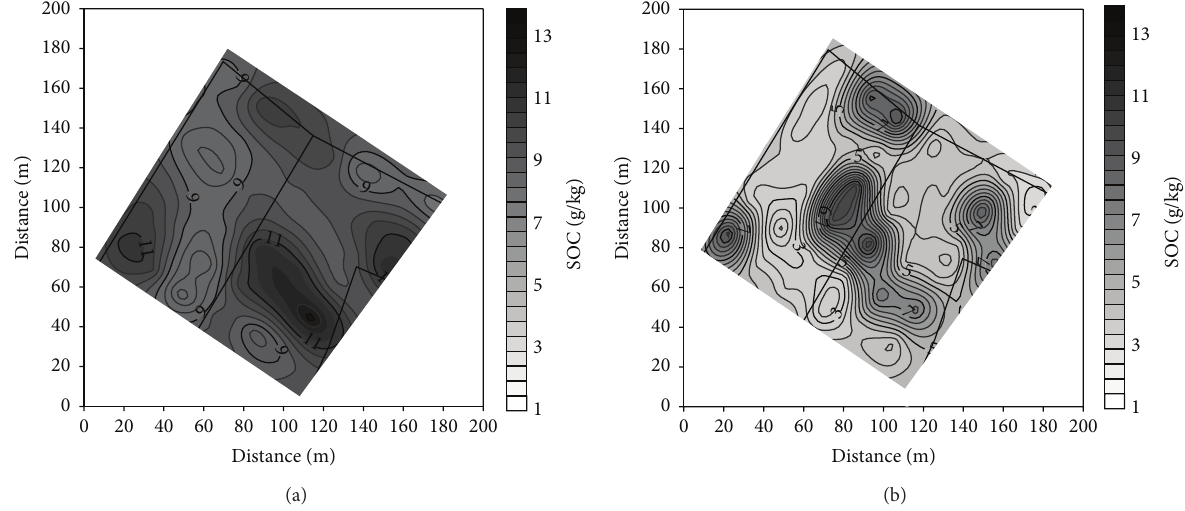
Figure 5: Distribution of SOC (g/kg) in the plowed layer (a) and subsoil (b).